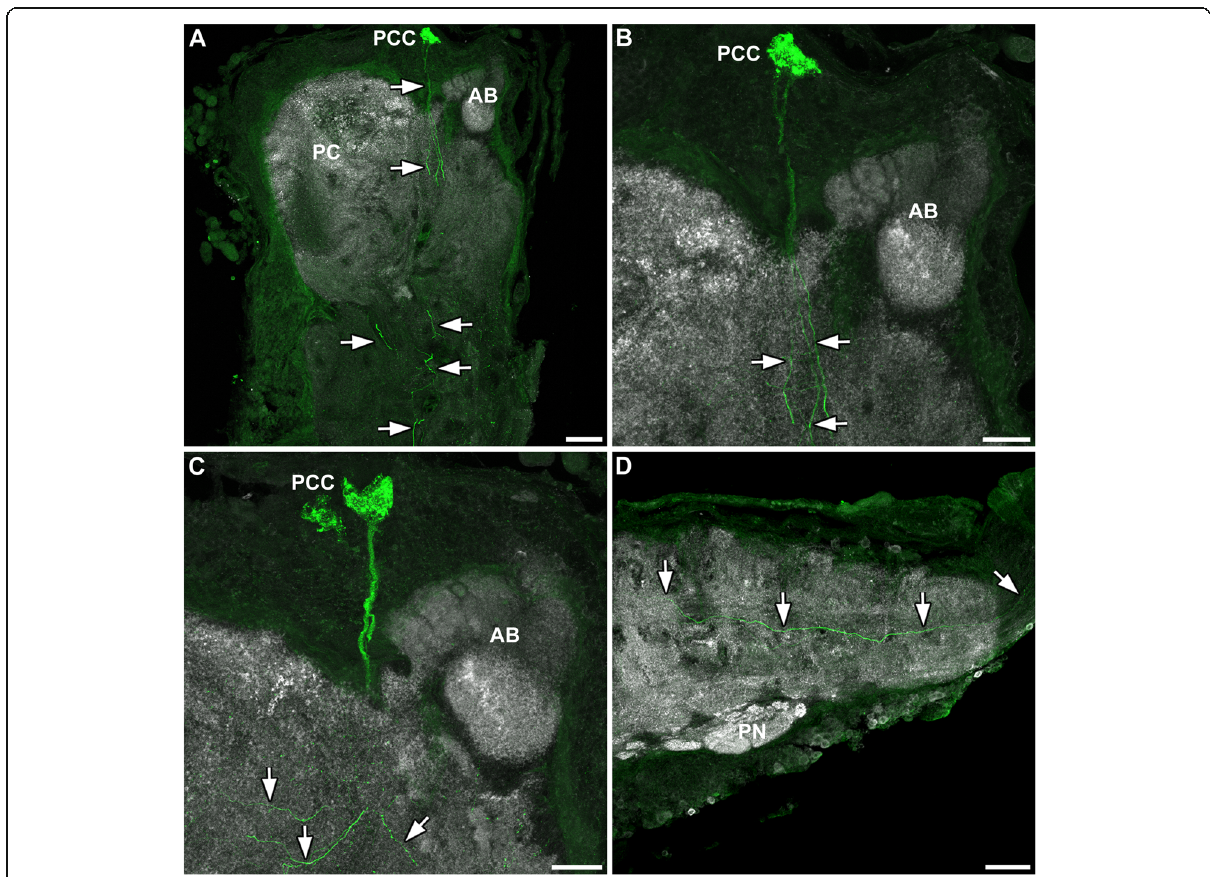
Fig. 8 Histaminergic neurons in the central nervous system of Euscorpius italicus . Sagittal sections (anterior to the left, ventral to the bottom) showing immunoreactivity of histamine (green) and synapsin (grey). a Three protocerebral histaminergic neurons (PCC) were identified anterodorsally to the arcuate body (AB). These somata sent projections ventrally toward more caudal body regions (white arrows). b Close-up of the PCC in A, revealing a single primary neurite for each immunoreactive cell body (white arrows). c These neurites innervated the whole nervous system, projecting not only caudally, but also anteriorly and posteriorly (white arrowheads). d The primary neurites innervated the entire nervous system, including the most posterior regions of the mesosoma (white arrows). Abbreviations: AB: arcuate body; PC: protocerebrum; PCC; protocerebral cell bodies; PN: pectine neuropil. Scale bars: a, d: 100 μ m; b, c: 50 μ